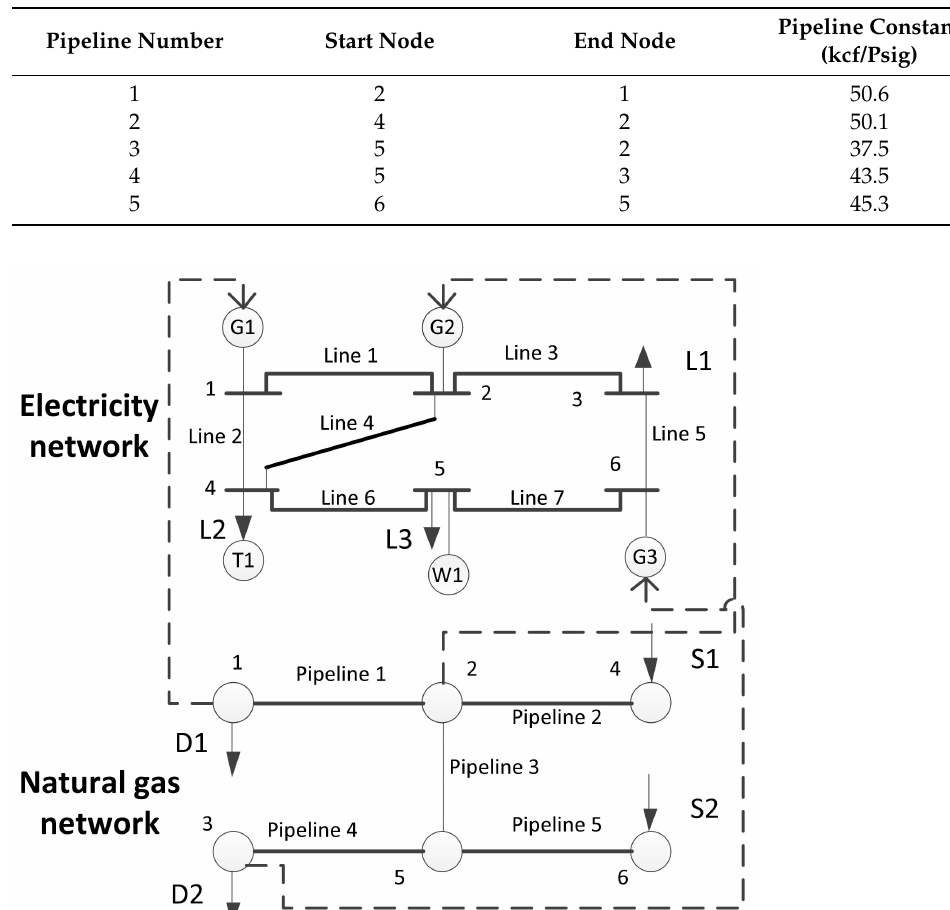
Table 2. Natural gas pipeline characteristics.